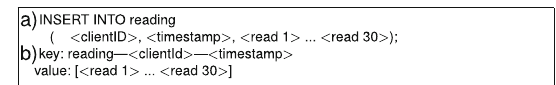
Fig. 9 Example of an insert query ( a ) mapping into a key-value pair ( b ). clientID and timestamp compose the primary key of the table and become part of the mapped key. The table has 30 attributes that were omitted for